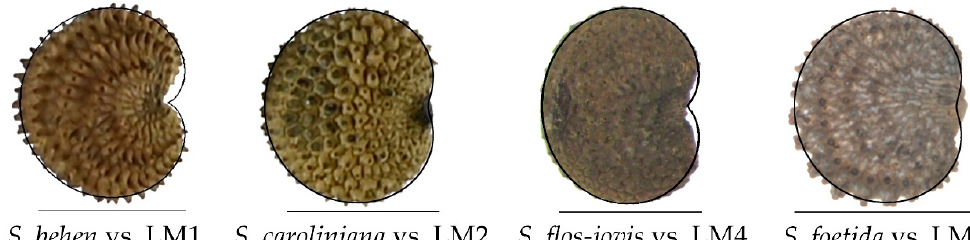
Figure 10. Representative images of the group of echinate seeds. The mean J index values obtained with the models shown are 90.3 for S. behen with LM1; 90.4 for S. carolininaa with LM2; 90.1 for S. flos-jovis with LM4; and 90.2 for S. foetida with LM2.